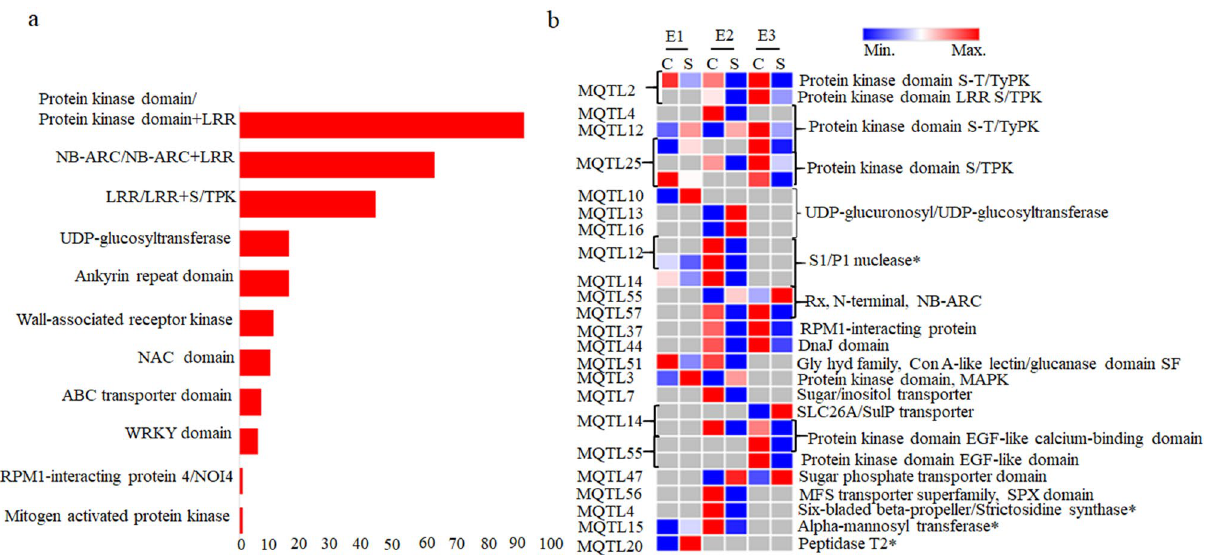
Figure 4. Important candidate genes: ( a ) histogram showing frequencies of CGs encoding proteins with 11 different domains involved in disease resistance; ( b ) heatmap showing 29 important differentially expressed CGs. C control, S stress, E1 experiment 1, E2 experiment 2, E3 experiment 3, S-T/TyPK serine-threonine/ tyrosine protein kinase, S/TPK serine/threonine protein kinase, LRR leucine rich repeats. Genes marked with asterix (*) had FC ≥ 5 or ≤ − 5.